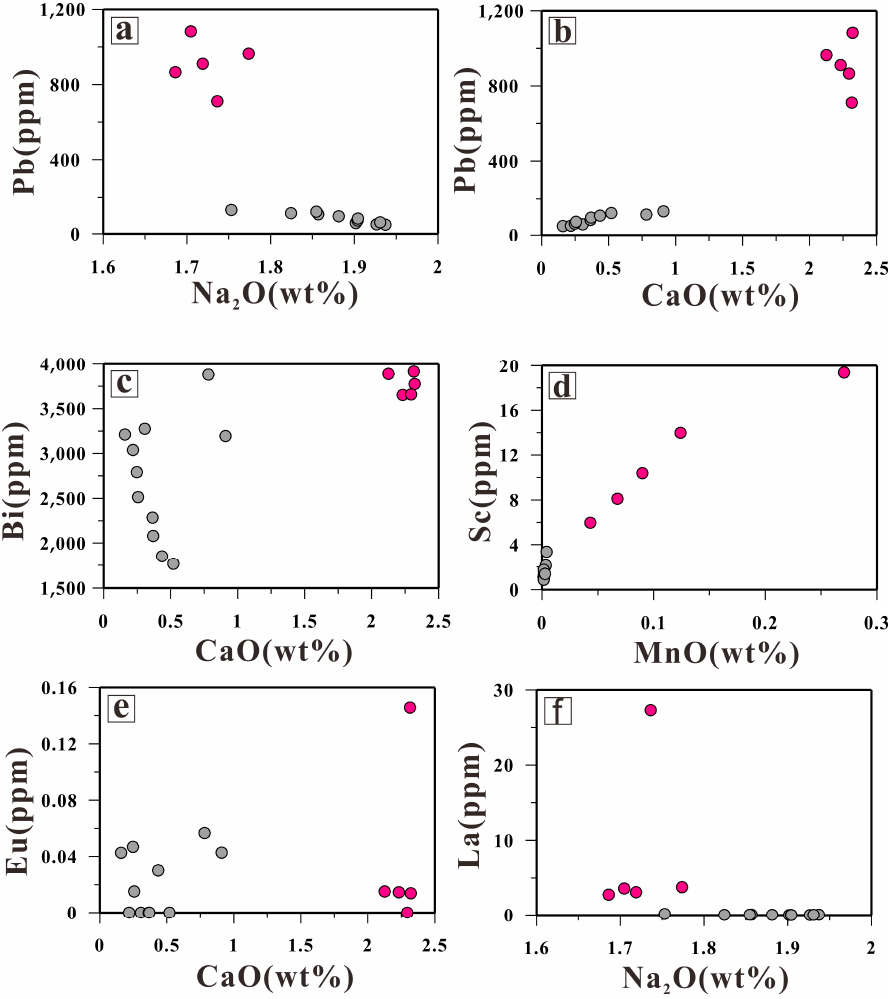
Figure 8. Relationship between major and trace elements: ( a ) Na 2 O vs. Pb; ( b ) CaO vs. Pb; ( c ) CaO vs. Bi; ( d ) MnO vs. Sc; ( e ) CaO vs. Eu; ( f ) Na 2 O vs.